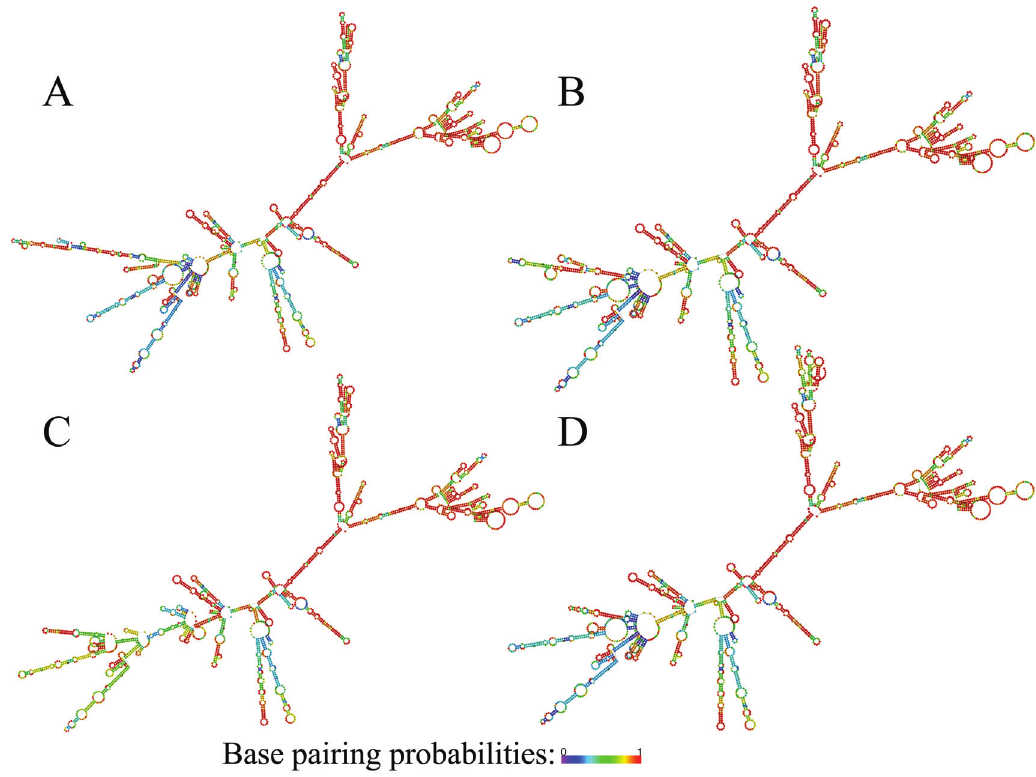
Figure 2 - Folding patterns of NQO1 transcript variants. A - transcript variant 1; B - transcript variant 2; C - transcript variant 3; D - transcript variant 4. Color-scale represents base pairing probabilities: violet and red correspond to 0 and 1 probabilities,